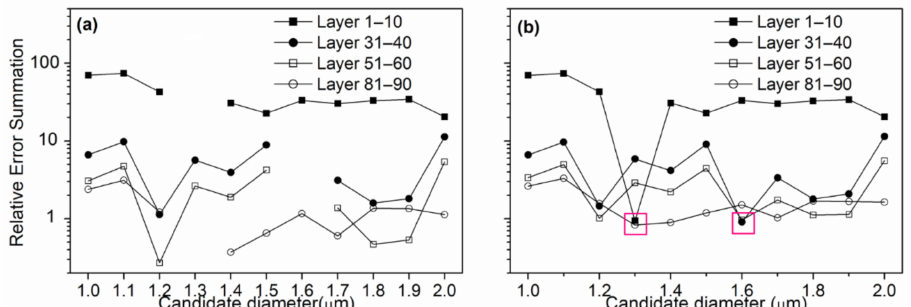
Figure 7. Relative error summation under different droplet diameters for each layer set: ( a ) Ground truth data from the time-based Markov Chain model without noise; ( b ) Ground truth data from the time-based Markov Chain model with 5% relative